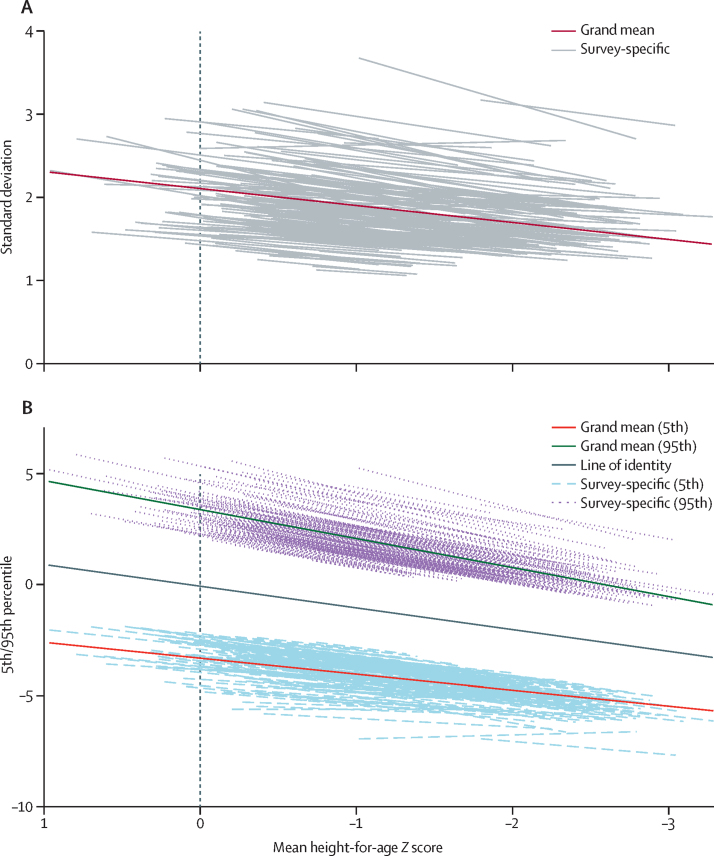
Predicted linear fit lines representing the associations of standard deviation (A) or fifth and 95th percentiles (B) of HAZ distribution with mean HAZFigure based on multilevel regression models for 2148 survey-age units. Trend lines for individual surveys are best linear unbiased predictions based on survey-level and country-level random intercepts and random slopes at the survey level. In panel A, the two surveys with predicted slopes that most differed from the grand mean slope was Uzbekistan 1996 (n=1086), for which the predicted slope was 0·041, and Guyana 2009 (n=1185), for which the predicted slope was 0·046. No other surveys had predicted slopes for the association of standard deviation with mean HAZ that indicated that standard deviation increased as mean HAZ declined. HAZ=height-for-age Z score.